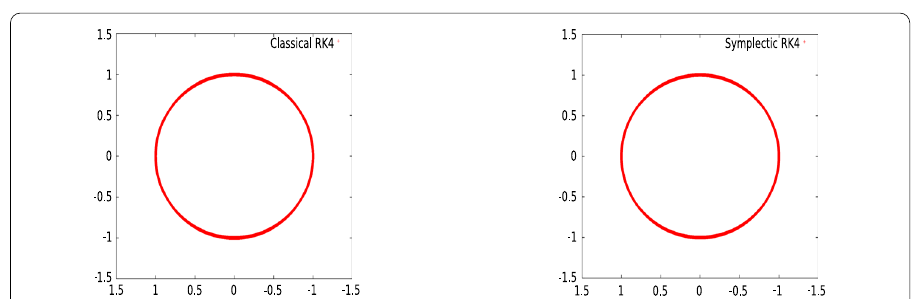
Fig. 9 Computed trajectories with RK4 and RK4sym. Square symmetric initial configuration